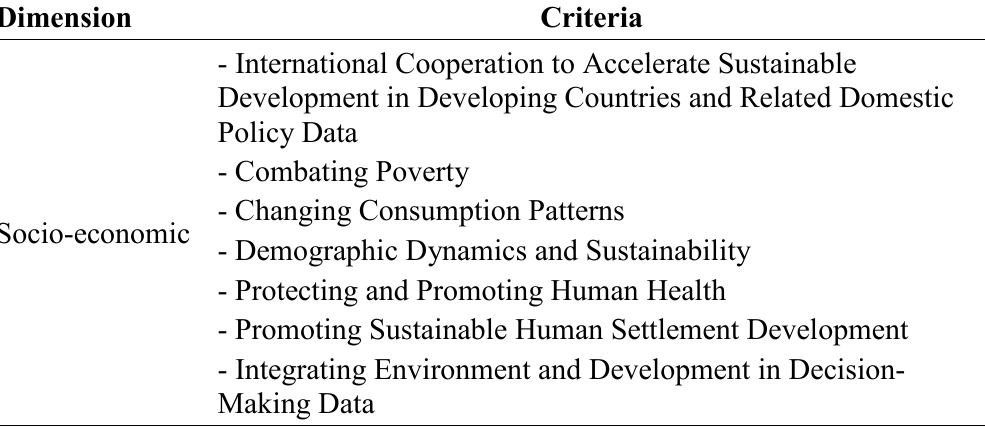
Table 1. Socio-Economic and Environmental Aspects and Criteria of Sustainable Development according to Agenda 21 (developed by the authors based on Agenda 21, 1992 (UN Documents, 2021), as cited in Kauskale (2018))